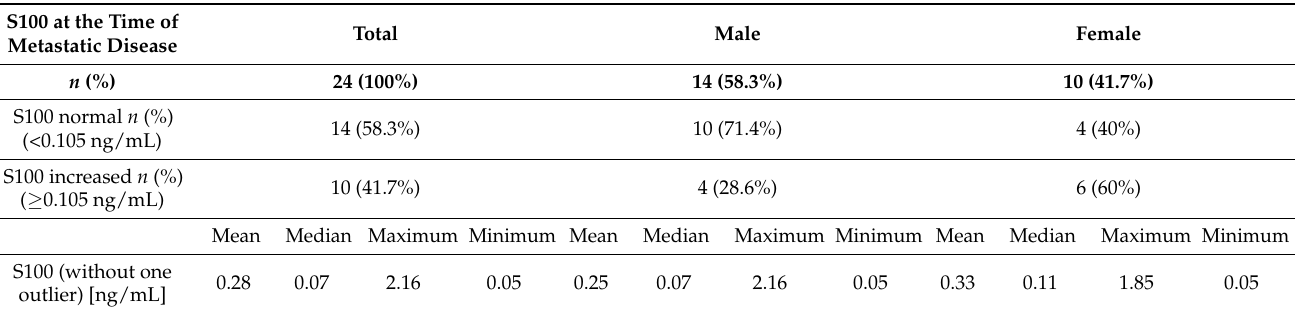
Table 3. Tumor marker S100, gender comparison. Normal S100 vs. increased values. One extraordi- nary outlier with S100 9.39 ng/mL was excluded from the calculation as it biases the overall picture in this smaller cohort.